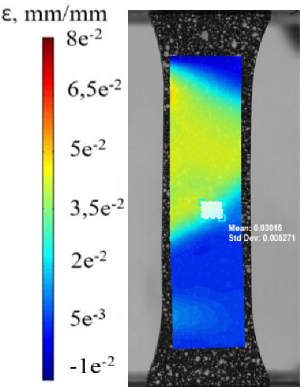
Figure 2. Qualitative analysis of the Lüders